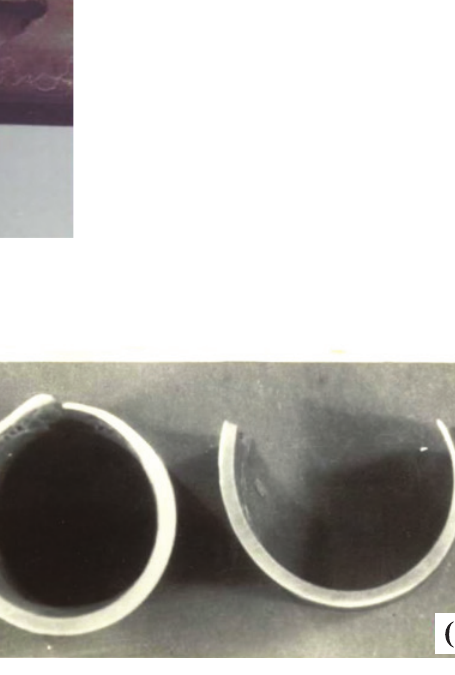
Fig. 4: Cross sectional view (a) in the vicinity of rupture and (b) in the vicinity of to be 10%. The wide open rupture exhibited typical ‘thin lip’ appearance with the edges drawn to a ‘knife edge pattern’, indicating plastic deformation of the metal over the localized area prior to rupture. The cross-sectional view of the tube in the vicinity of rupture is shown in Figure 4(a). The crack location showed a typical ‘thick lip’ appearance associated with localized plastic deformation of the tube material. A view of the cross-section of the tube at the location of the crack as shown in Figure 4(b) reflects thinning of the tube. The chemical composition of the tube conforms to the material specification BS: 3059/622/50 for this tubing. The estimated compositions of the outer side oxide scale of the tube are shown in Table 2. The fire side oxide layer on external surface of the tube was the result of flue gas-metal reaction as shown by some earlier investigators [5, 12]. Mainly, high velocity flue gas streams could have possibly eroded the fire side of the reheater tube. The micrographs in Figures 5(a) and 5(b) reveal thickness profile of fire side and steam side oxide layers. The thicknesses of these layers are of the order of 1.05 mm